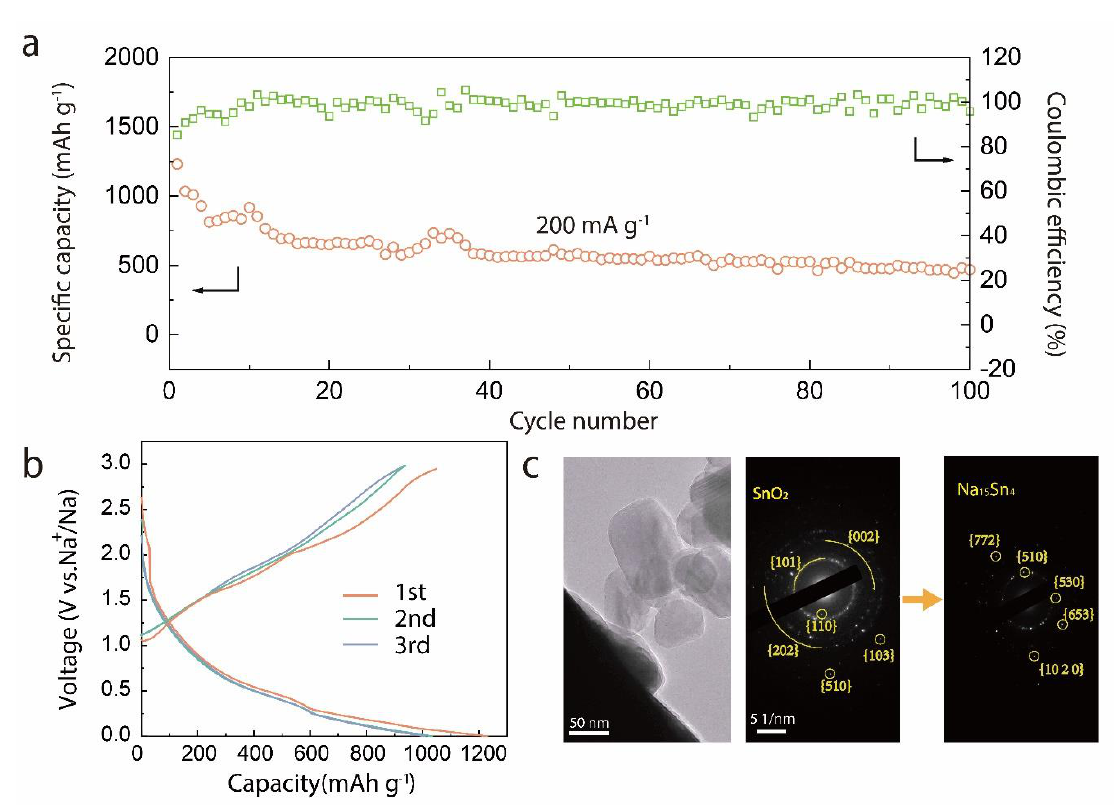
Figure 4. ( a ) Discharge capacity of the Gr-SnO 2 nanoparticles for the 100 galvanostatic cycles. The current density of 200 mA · g − 1 is used for all the cycles. ( b ) Galvanostatic charge/discharge curves of Gr-SnO 2 nanoparticles at 200 mA · g − 1 . ( c ) The HRTEM images of the Gr-SnO 2 nanoparticles and the SAED pattern of the unsodiated and sodiated Gr-SnO 2 nanoparticles.